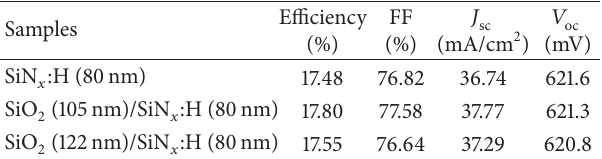
Table 1: Summary of the average electrical parameters of the different ARC stacks compared with SiN 𝑥 :H SARC solar